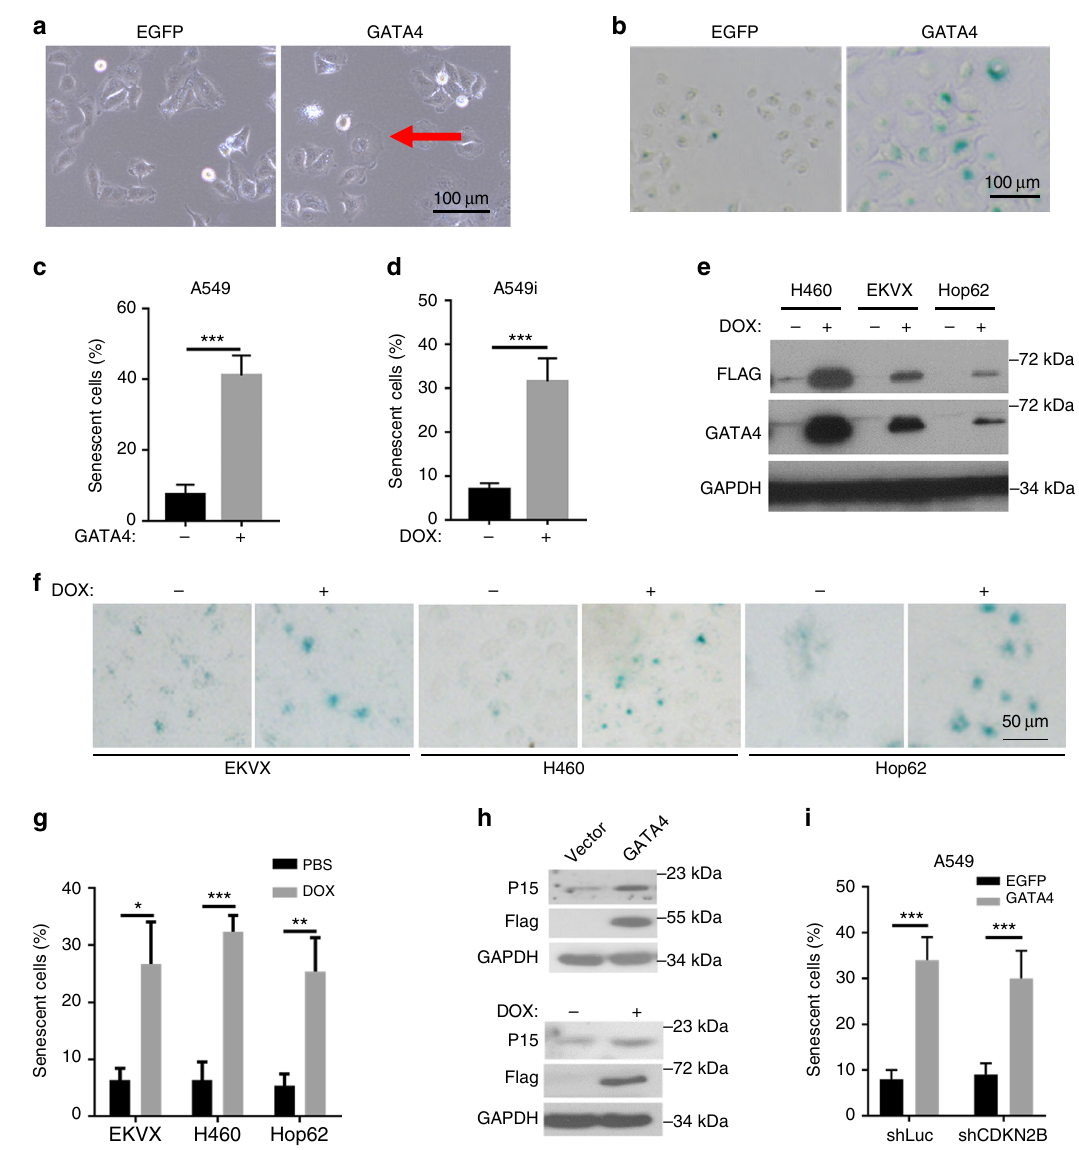
Fig. 2 Ectopic GATA4 expression induces lung cancer cell senescence. a Microphotograph of A549 cells infected lentivirus overexpressing GATA4. Red arrow-head highlighted the senescent cells. Scale = 100 μ m. b β -galactosidase staining of A549 cells infected with GATA4 or EGFP expressing lentivirus. Representative pictures were shown. Scale = 100 μ m. c , d Statistics of β -Galactosidase staining of A549 cells ectopically expressing GATA4 through lentivirus infection ( c ) or Doxycycline treatment of A549i cells ( d ) ( n = 3 per group). e Western blot analysis of Doxycycline-inducible GATA4 expression in stable cell lines of H460, EKVX, and Hop62. f β -Galactosidase staining of indicated cell lines before and after GATA4 expression. g Statistics of f ( n = 3 per group). h Western blot analysis of p15INK4b expression in GATA4-expressing A549 cells. i β -galactosidase staining of GATA4-expressing A549 knockdown with control or CDKN2B-targeting shRNAs ( n = 3 per group). Bars are represented as mean ± SEM of the indicated number ( n ) of repeats. *P < 0.05, **P < 0.01, and ***P < 0.001 by Student ’ s t